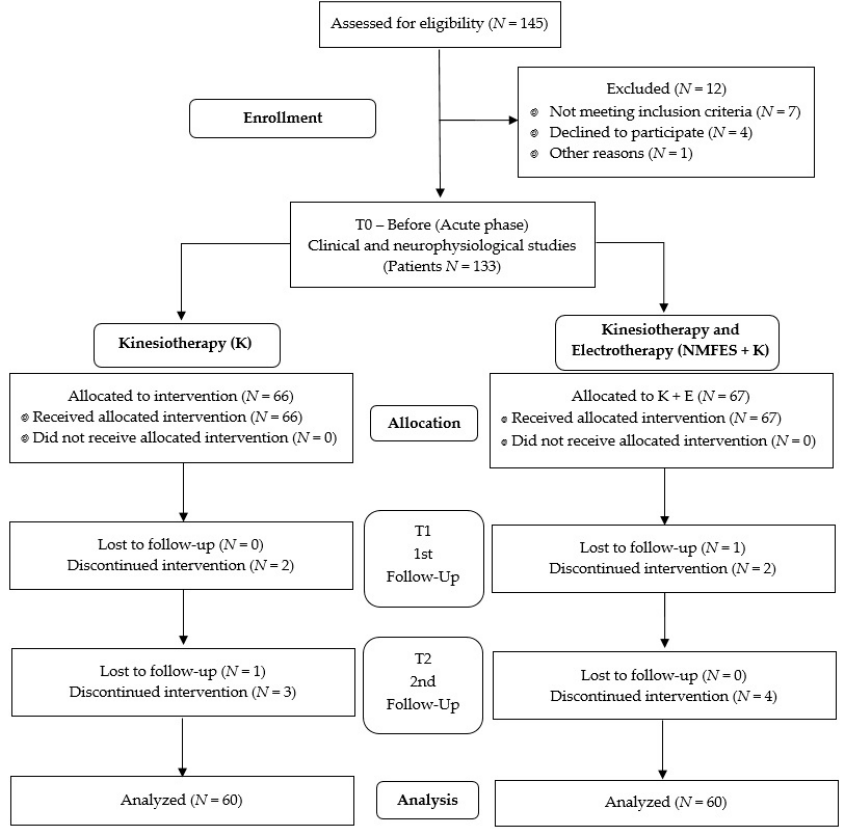
Figure 1. Flow chart of the study.